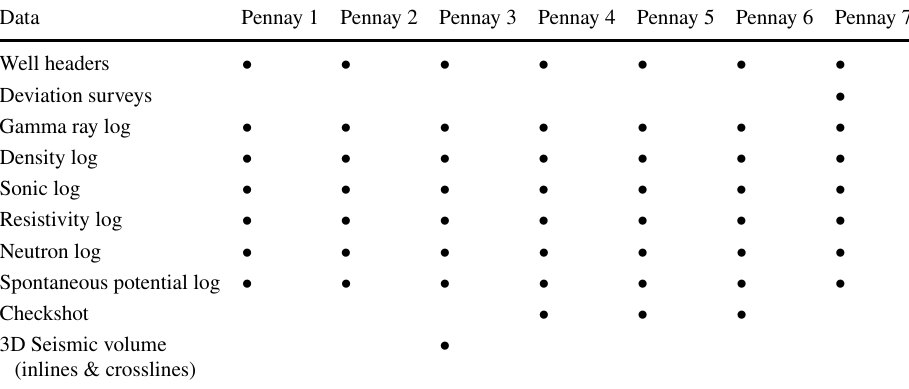
Table 1 Data available for